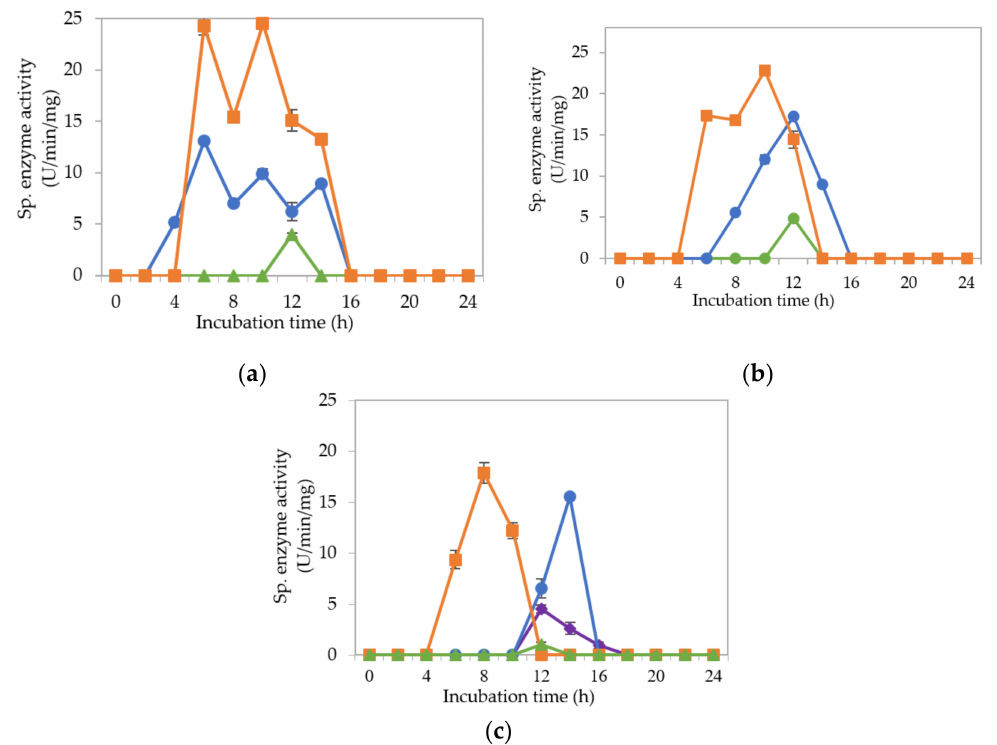
Figure 2. Specific extracellular cellulolytic and hemicellulolytic activities; ( • ) endoglucanase; ( (cid:4) ) exoglucanase; ( (cid:78) ) β -glucosidase and ( (cid:7) ) mannanase of Lactobacillus plantarum RI 11 grown in MRS control medium for 24 h. The enzyme activities were detected at three di ff erent pH levels: ( a ) pH 5; ( b ) pH 6.5; ( c ) pH 8. The error bars represent the standard deviation of specific enzyme activity of triplicate samples ( n =